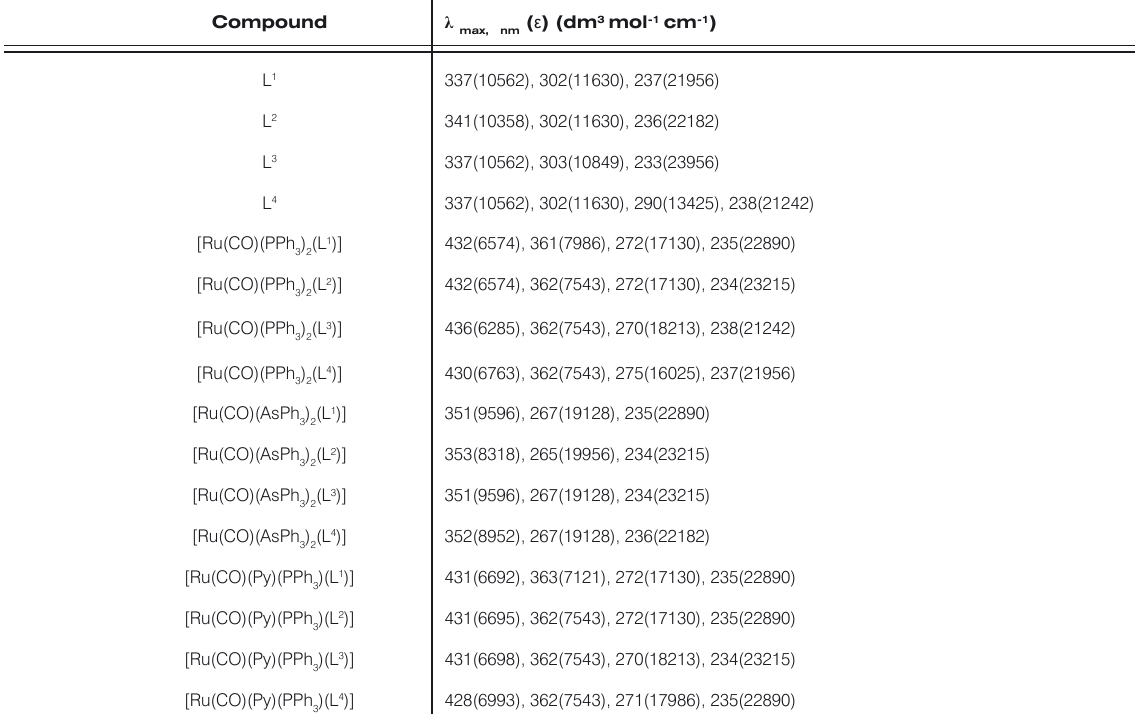
Table 3. UV-vis spectroscopic data of free ligands and their ruthenium(II) chalcone thiosemicarbazone complexes.